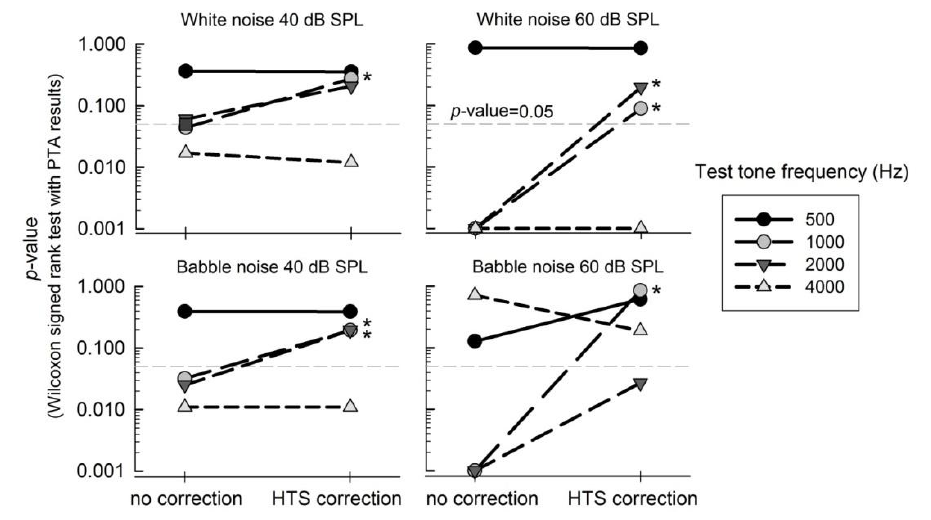
Figure 7. Effect of HTS correction on the similarity with PTA thresholds (n = 42). The environmental noise was white and babble noise at 40 and 60 dB SPL. Each symbol indicates the frequencies of each test tone. See the text for the description of